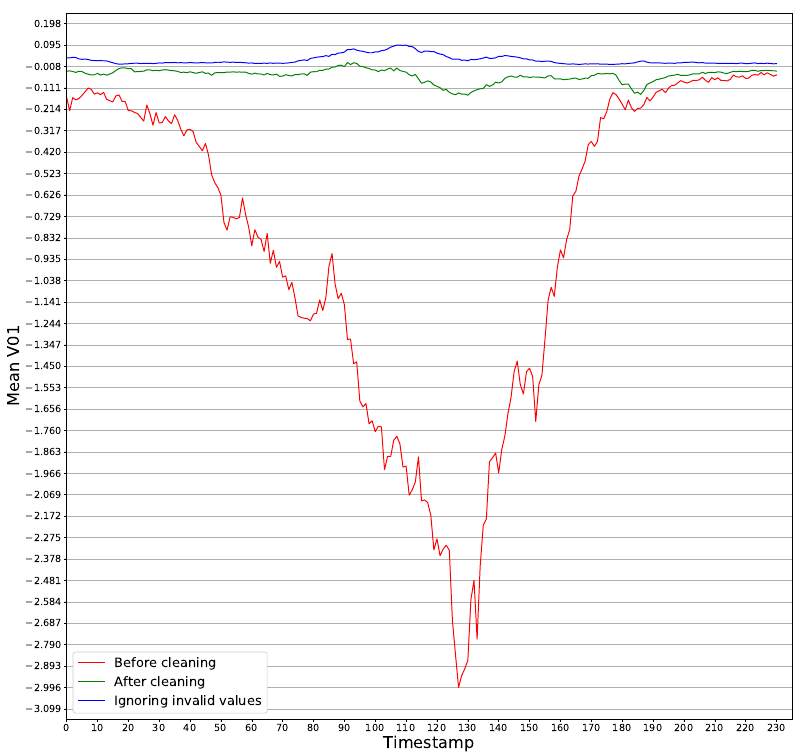
Figure 6. Time series plot for average V 01 values: ignoring invalid values, before and after